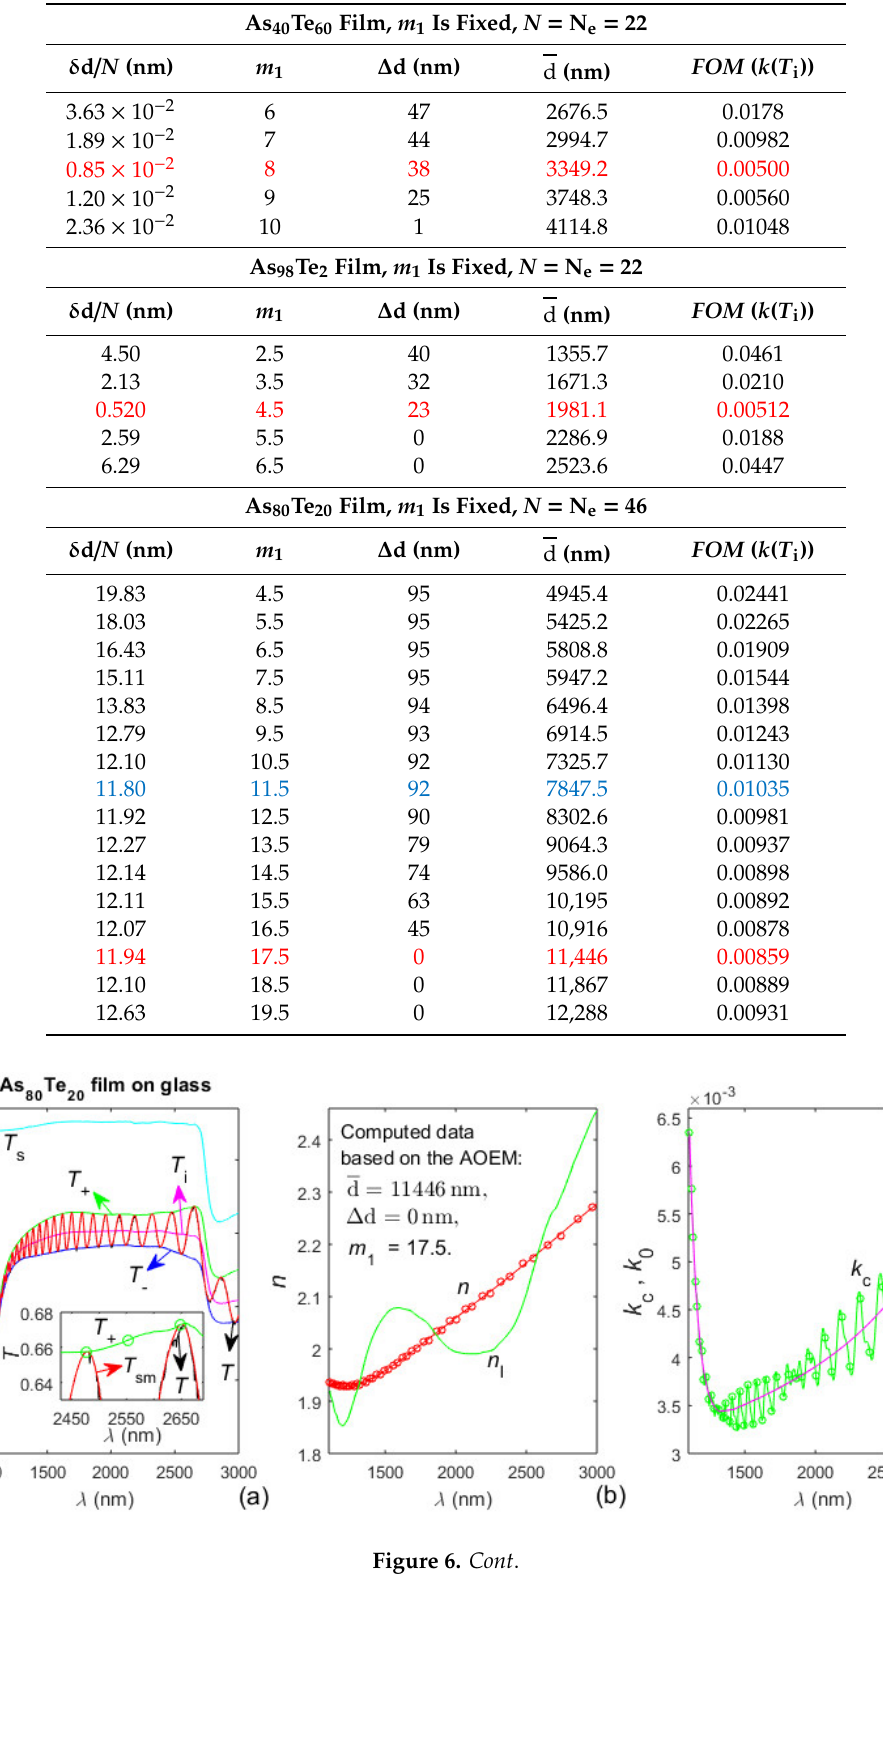
Figure 6. Input data and computed results from the characterization of the As 80 Te 20 film based on the AOEM with d , ∆d, and m 1 listed in red in Table 1. ( a ) T s ( λ ), T ( λ ), T sm ( λ ), its envelopes T + ( λ ) and T − ( λ ), and T i ( λ ); ( b ) n ( λ ) and n l ( λ ); ( c ) k c ( λ ) and its optimized curve fitted k 0 ( λ ); ( d ) k ( T + ) computed from Equation (2), k ( T i ) from Equation (8) and k = k 0 + Δ k ; ( e ) T ( λ ) and T r ( λ ) computed using k = k 0 + Δ k ; and ( f ) difference between T ( λ ) and T r ( λ ) with k ( T i ), k ( T + ) and k = k 0 + Δ k . 3.5. Additional Results about the As x Te 100−X Films Other data regarding characterizations of the three studied films based on the AOEM are presented in Table 2, as the data about the As 40 Te 60 and As 98 Te 2 films refer to the characterizations represented by Figures 3 and 4. The data related to the As 80 Te 20 film and designated as “ m 1 = 11.5, ND” and “ m 1 = 17.5, AD” refer to the characterizations represented by Figures 5 and 6 respectively, as “ND” denotes normal dispersion and “AD”—anomalous dispersion. Since n ( λ ) from Figure 5b does not demonstrate anomalous dispersion and its respective n l (max( λ )) − n (max( λ )) is quite large, one more characterization of the As 80 Te 20 film is performed using the film data typed in Figure 5b and n ( λ ≤ λ b ) from Figure 5b, however employing n ( λ > λ b ) = n e ( λ > λ b ). Taking into account that this characterization recognizes the presence of anomalous dispersion, it is denoted as “ m 1 = 11.5, AD”. However, the FOM data from Table 2 show that this particular characterization is most inaccurate amongst the three represented there characterizations of the As 80 Te 20 film.